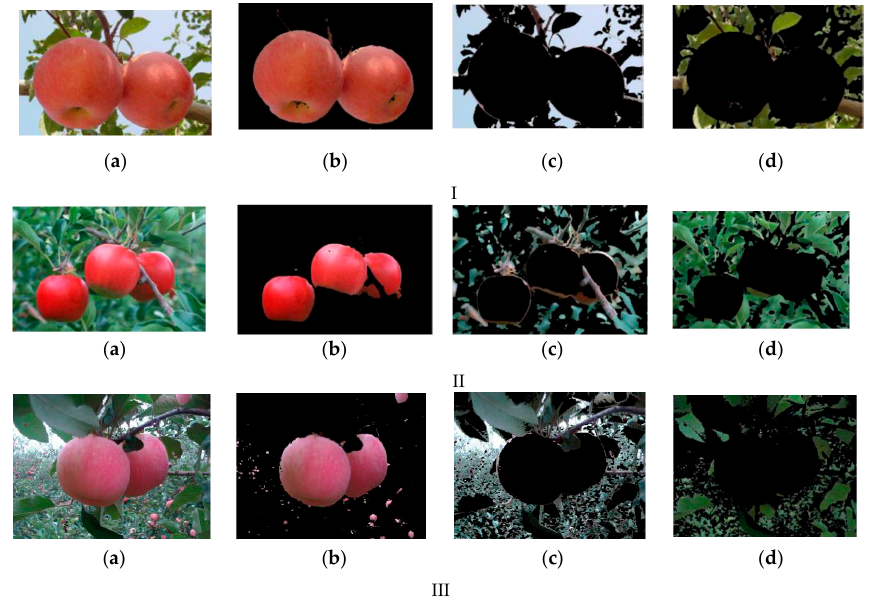
Figure 4. Result of the K-means segmentation: ( a ) original image; ( b ) overlapped apples; ( c ) sky; ( d ) branches and leaves.